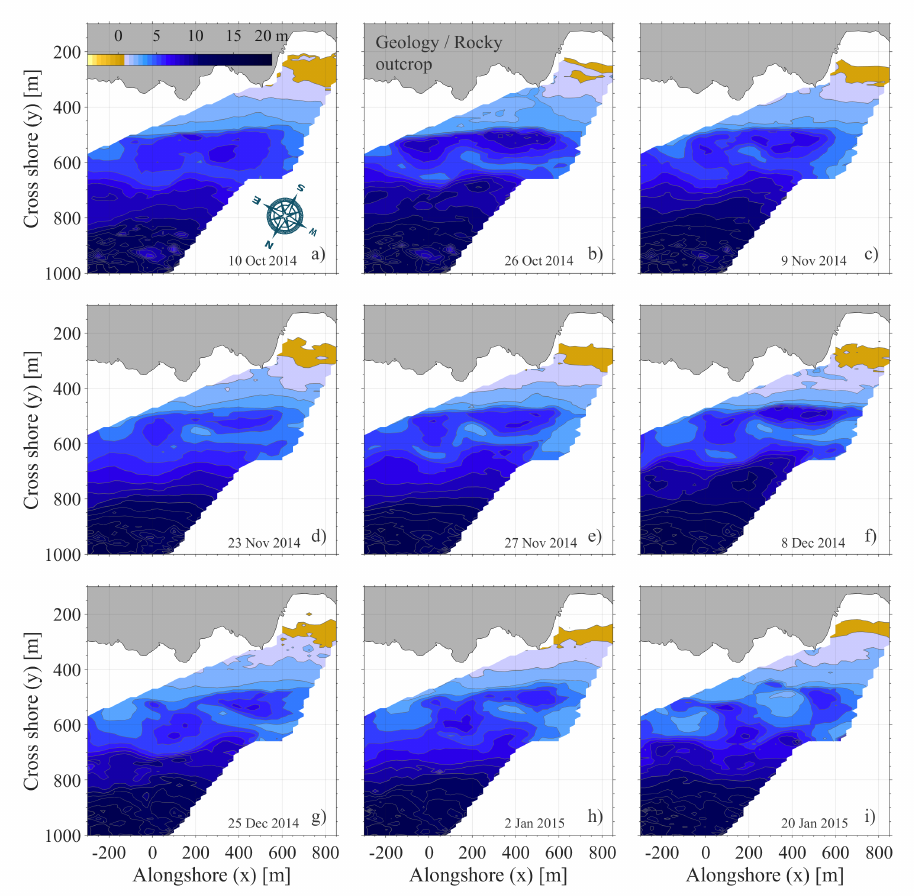
Figure 6. Video-derived bathymetry sequence covering a period from 10 October 2014 ( a ) to 20 January 2015 ( i ). Similarly to Figure 4 moments in between this period are shown in which ( b ) is 26 October 2014, ( c ) 9 November 2014, ( d ) 23 November 2014, ( e ) 27 November 2014, ( f ) 8 December 2014, ( g ) 25 December 2014 and ( h ) 2 January